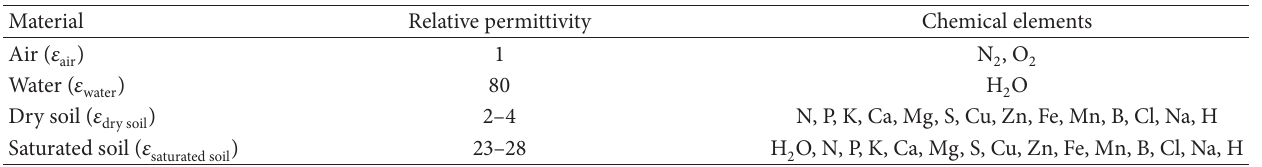
Table 3: Relative permittivity of material properties.